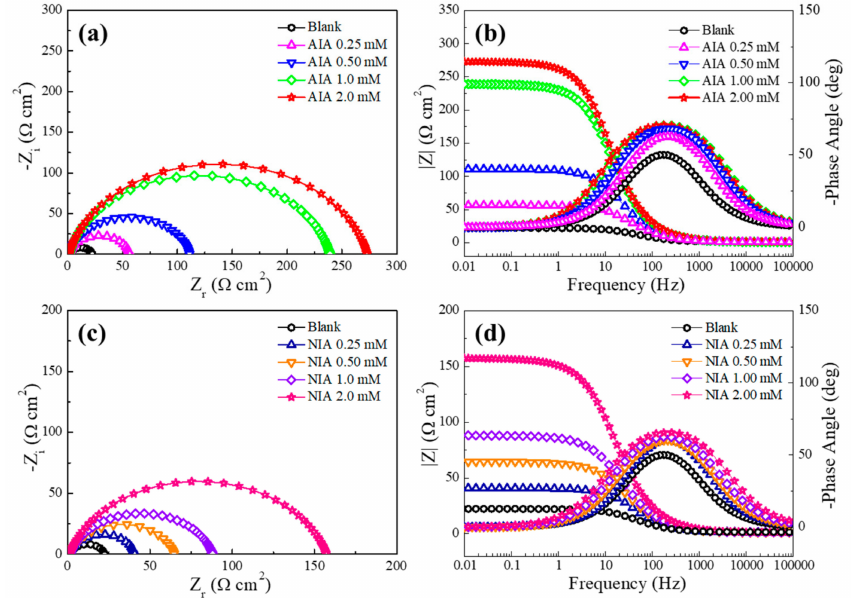
Figure 2. The plots of Nyquist and Bode for carbon steel in 1 M HCl with and without di ff erent concentrations of 5-aminoindazole (AIA) and 5-nitroindazole (NIA) at 298 K. AIA: ( a , b ); NIA: ( c , d